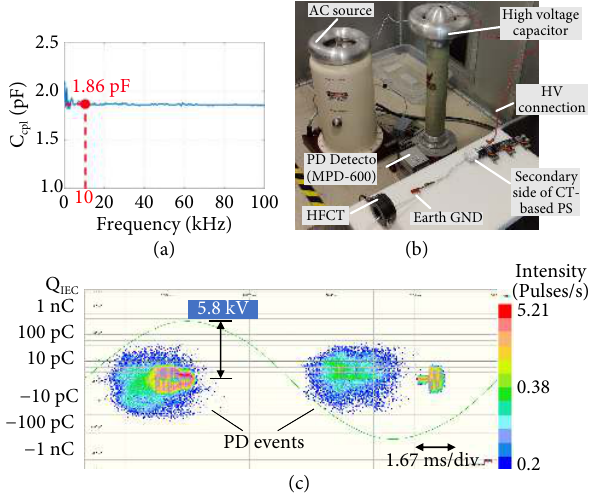
Fig. 5 (a) Coupling capacitance measurement results. (b) Setup for insulation test. (c) PD test result for design CT-based